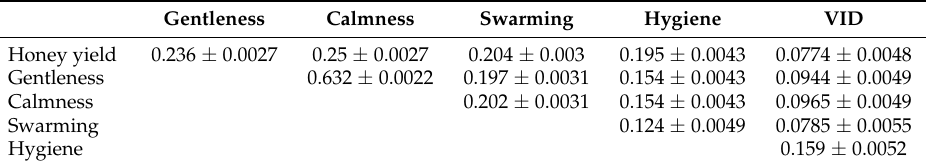
Table 6. Pearson correlations with standard errors between phenotypes corrected for apiary/year effects obtained from the breeding value estimation. Correlation is calculated only from pairs of colonies with five measurements per